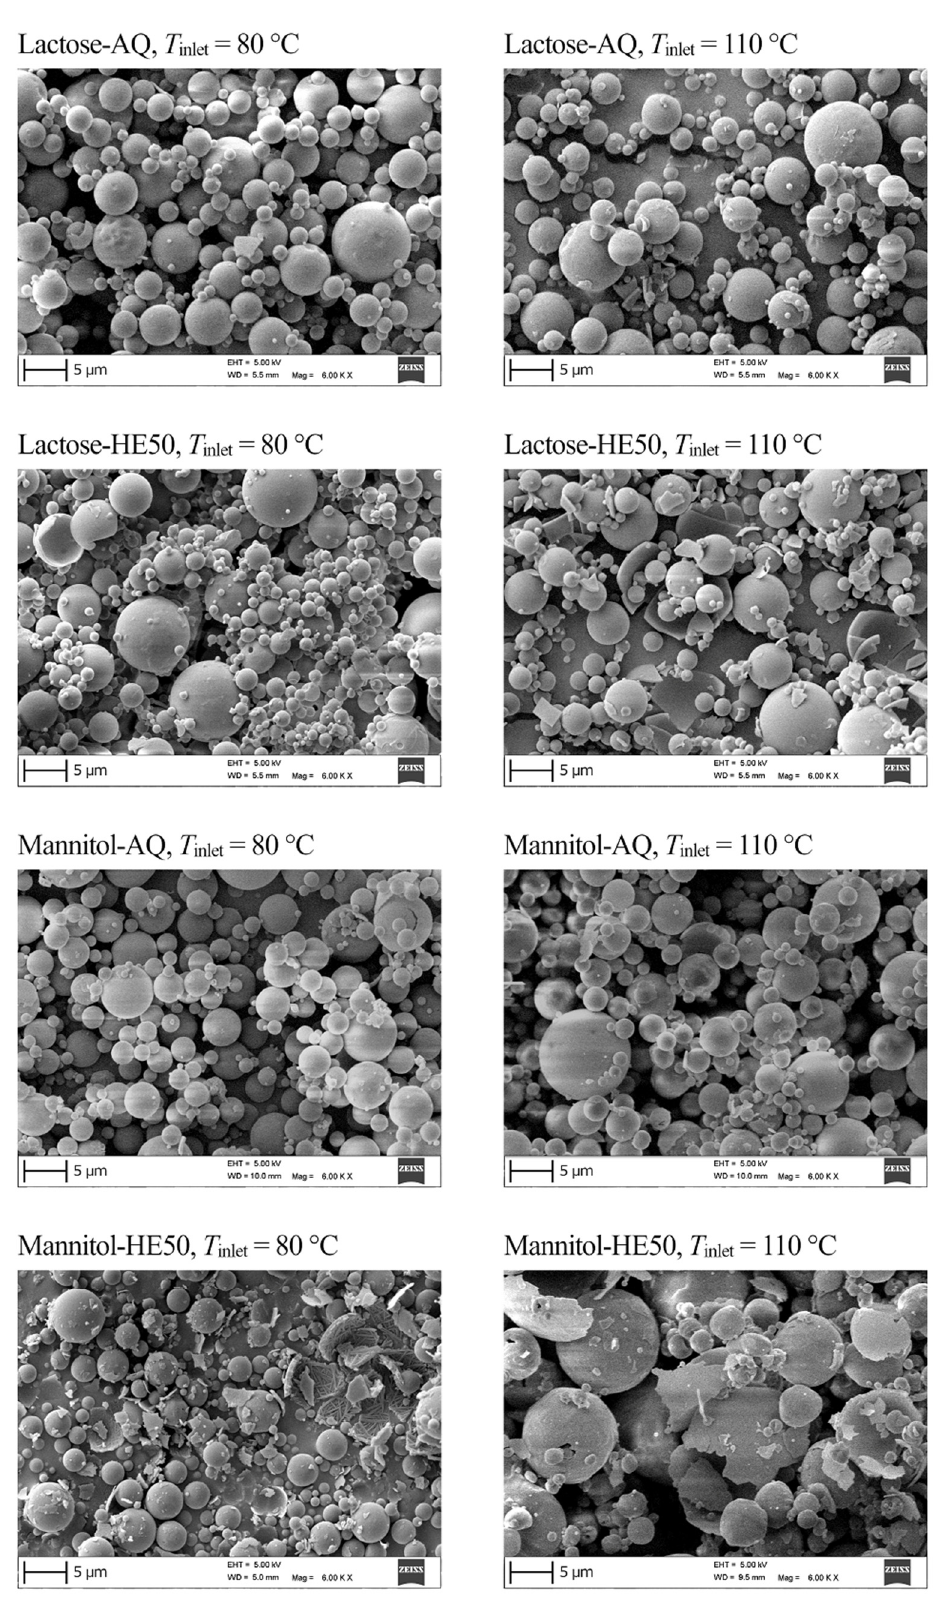
Figure 2. Scanning electron micrographs of nano spray-dried lactose and mannitol powder materials. Presented micrographs are for materials prepared by spray drying of aqueous (AQ) or hydroethanolic (HE50) solutions with a solute concentration of 1.50% w / w at an inlet temperature, T inlet , of 80 or 110 ◦